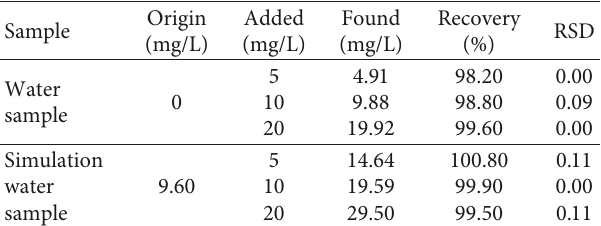
Table 2: The recovery test results of extraction by IL-2.